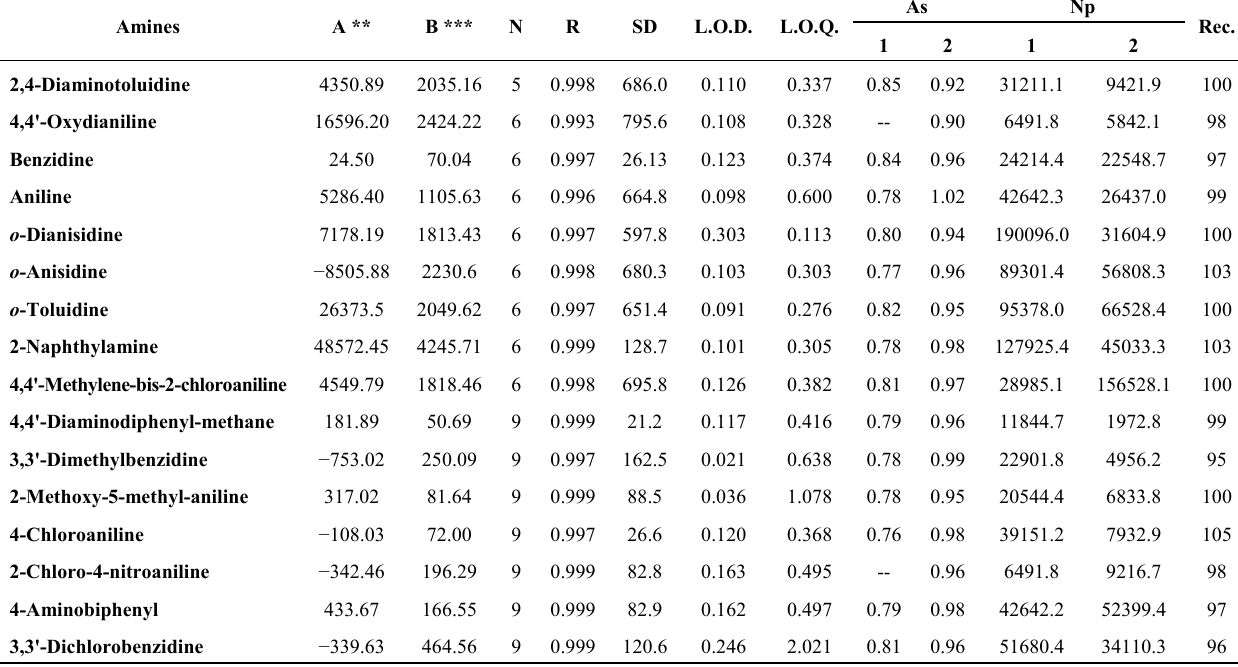
Table 2. Analytical parameters HPLC/ED from 16 aromatic amines, flow rate: 0.8 mL·min − 1